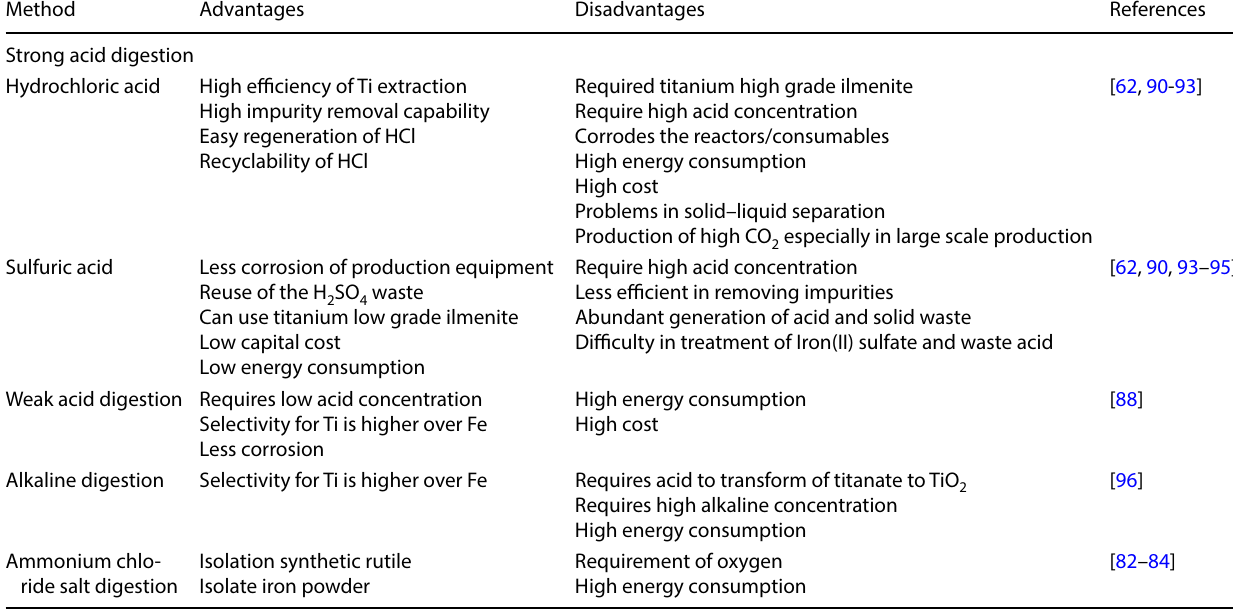
Table 7 Advantages and disadvantages of treatment